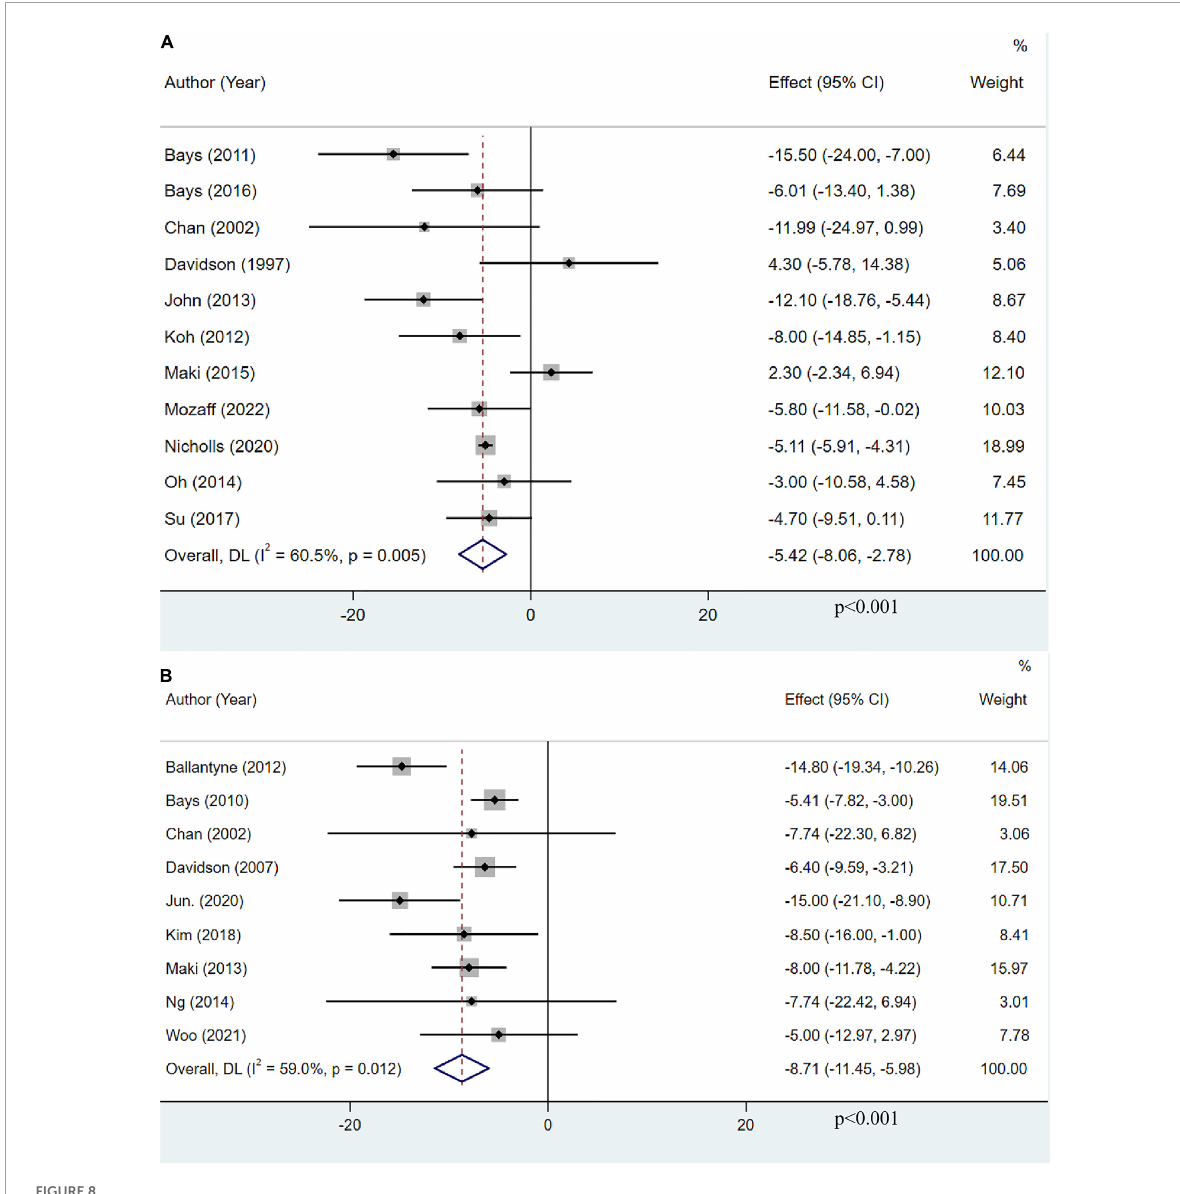
the LDL-C lowering effect of statins outweighed the impact of OM3-FA in raising